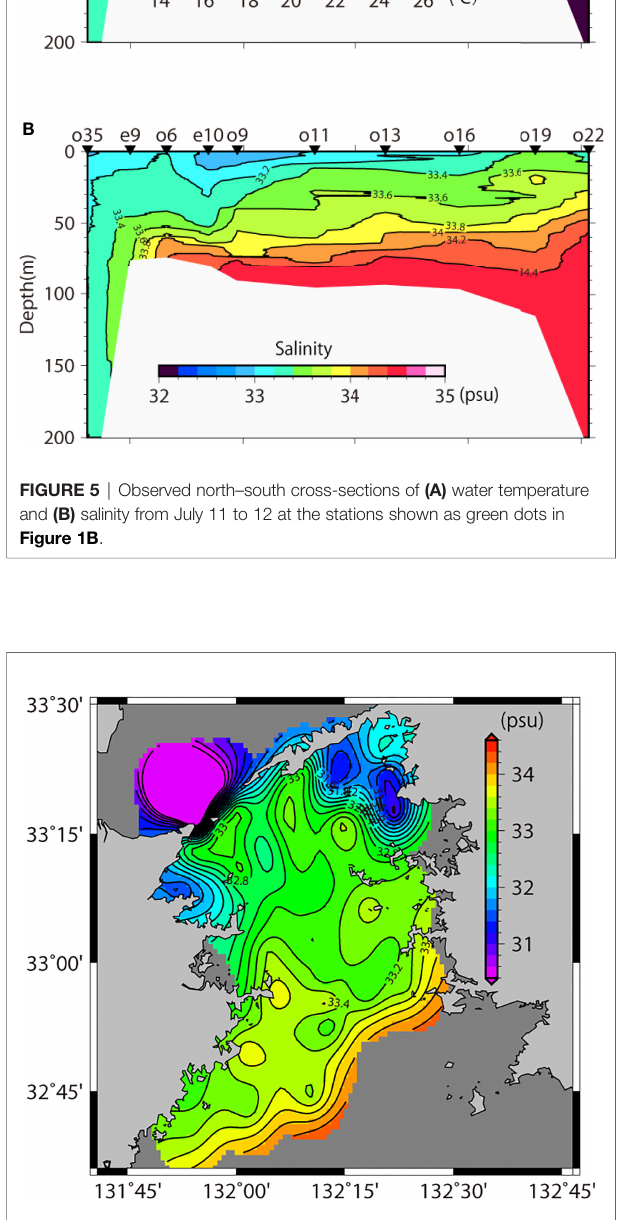
FIGURE 6 | Horizontal distribution of sea surface salinity observed during July 10 – 13,